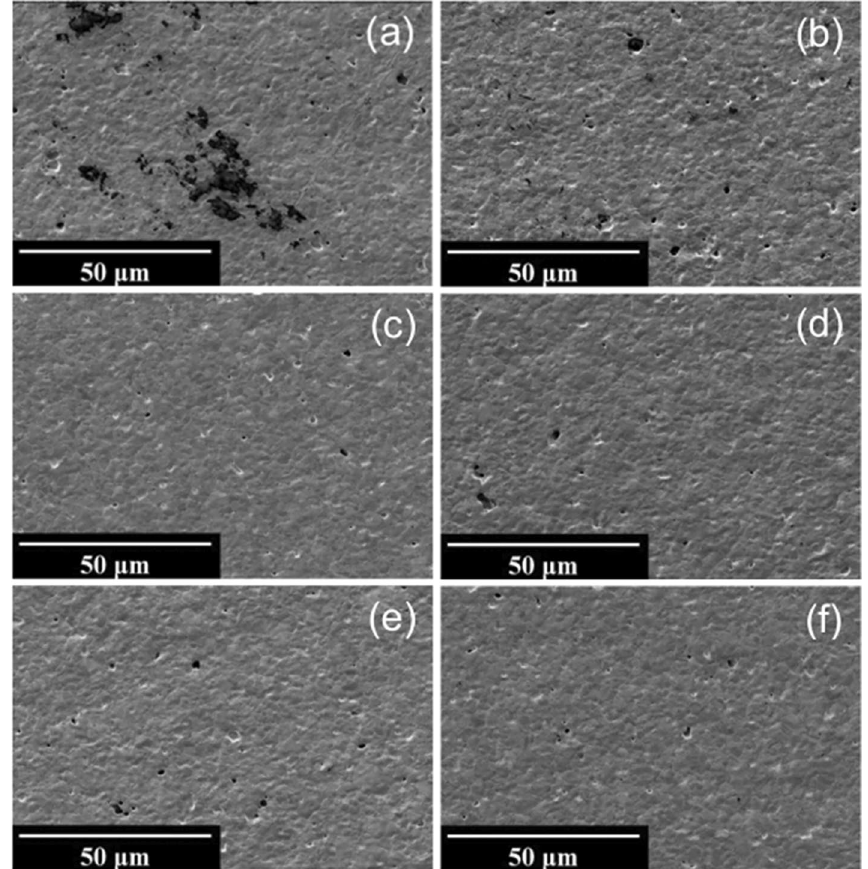
Figure 4. Scanning electron micrographs of LTCC surfaces ( a ) Uncleaned, ( b ) UV-O 3 , ( c ) Piranha, ( d ) KOH +